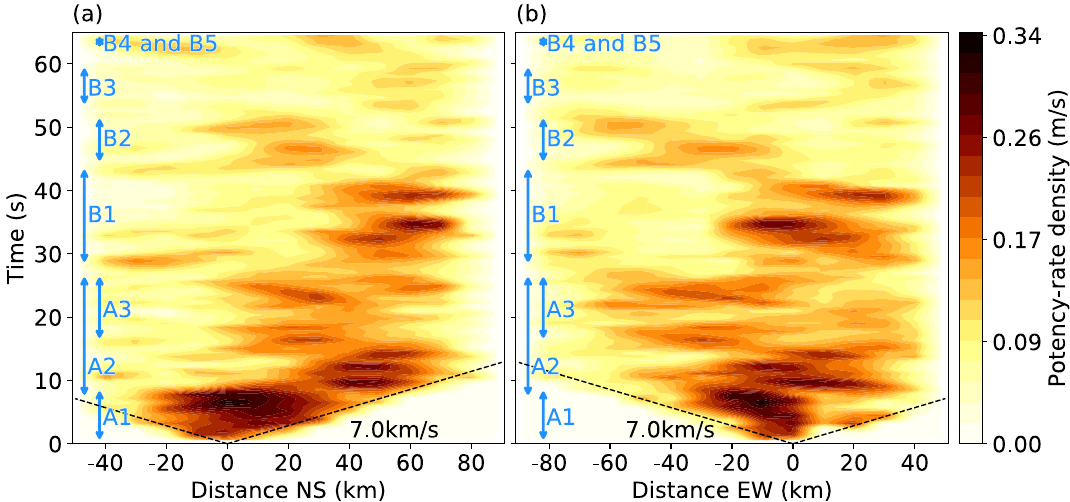
Figure 4. Time evolution of potency-rate density distribution, projected along ( a ) north–south and ( b ) east– west directions, where the positive distance directs toward ( a ) north and ( b ) east from the epicenter. North– south and east–west distances are measured along the dashed lines on the left-top panel of Fig. 3a. The dashed line represents the reference rupture speed. Each rupture phase is annotated on left of each panel. This figure was made with matplotlib (v3.1.1) 48